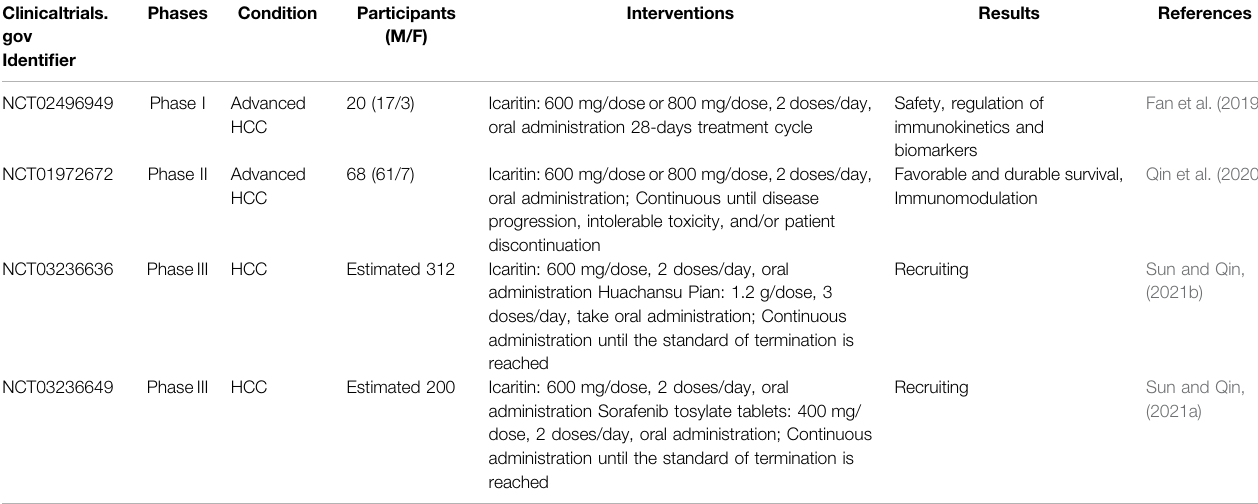
TABLE 6 | Effects of icaritin on HCC evaluated in clinical studies. Clinicaltrials.